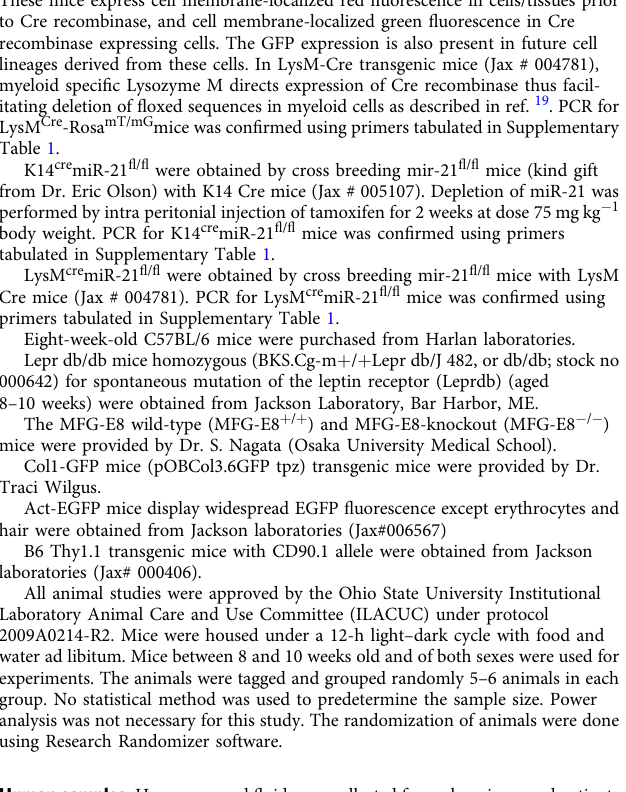
Hunt/Schilling cylinder for wound fl uid collection . Wire mesh cylinder (stainless steel; 2.5cm length and 0.8 cm diameter) were implanted subcutaneouly on the dorsal side of mice. The wound fl uid collected in these cylinders was harvested on d3 post implantation 19 . Polyvinyl alcohol sponge implantation and isolation of macrophages . Circular (8 mm) sterile polyvinyl alcohol (PVA) sponges were implanted subcutaneously on the dorsum of the mice 19 . Sub-cutaneously implanted PVA sponges were harvested on days 3 and 7 post implantation. Macrophages were isolated by magnetic cell sorting using anti-CD11b-tagged microbeads (Miltenyi Biotec, CA).